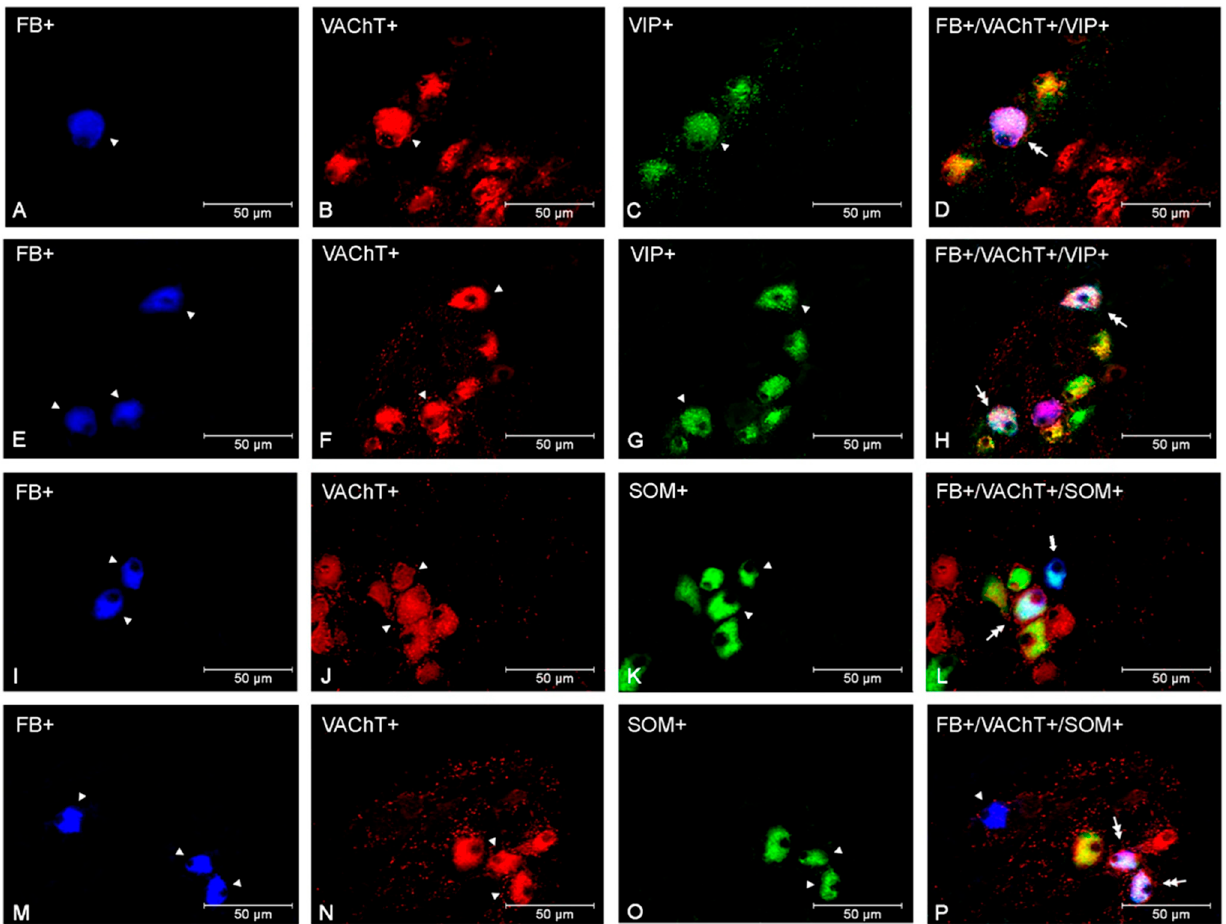
Figure 2. Micrographs demonstrating the presence of VAChT ( B , F , J , N ), VIP ( C , G ), and SOM ( K , O ) in the PCG uterine perikarya of gilts from the saline ( A – D ), control ( I – L ), and E . coli ( E – H , M – P ) groups. The arrowhead indicates a Fast Blue (FB)-positive neuron, a perikaryon immunoreactive to VAChT, VIP, and a perikaryon immunoreactive to SOM. The double arrow indicates an FB-positive uterine neuron expressing VAChT and VIP and VAChT and SOM. The arrow indicates an FB-positive perikaryon expressing SOM. The photographs ( D , H , L , P ) were made using the digital superimposition of three color channels: FB-positive (blue), VAChT-positive (red), and SOM- or VIP-positive (green). One VAChT and VIP immunoreactive uterine neuron is visible in the gilt of the saline group ( A – D ). In the PCG of the E . coli group, an elevated number of perikarya expressing these substances are visible ( E – H ). One perikaryon expressing SOM and VAChT is present in the ganglion of the control group ( I – L ). In the E . coli group, two perikarya expressing both of these substances are observed in the PCG ( M – P ).